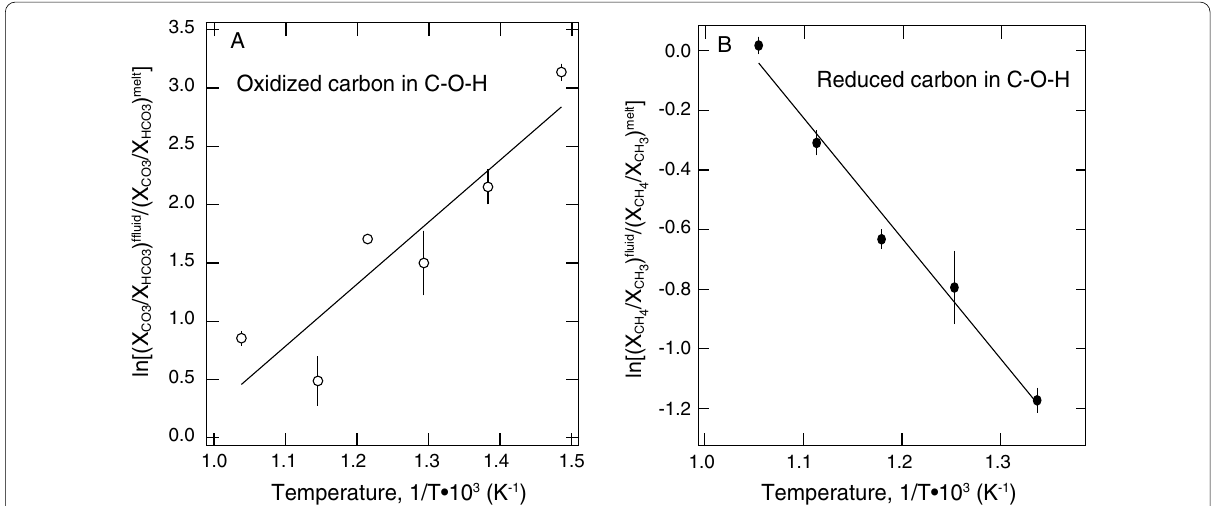
Fig. 3 Exchange equilibrium coefficients of carbon species from Eqs. (1) and (2). A . From Eq. (1), which describes the equilibrium under oxidizing conditions. B . From Eq. (2), which describes the equilibrium under reducing